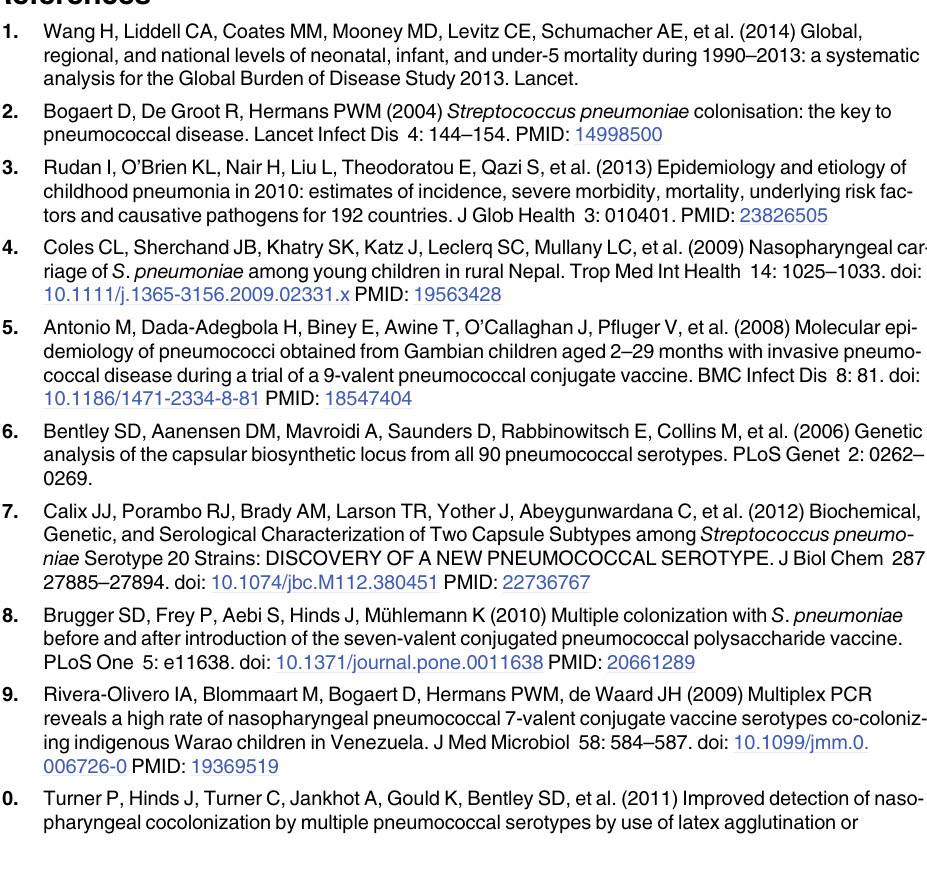
S2 Table. Sequetyping